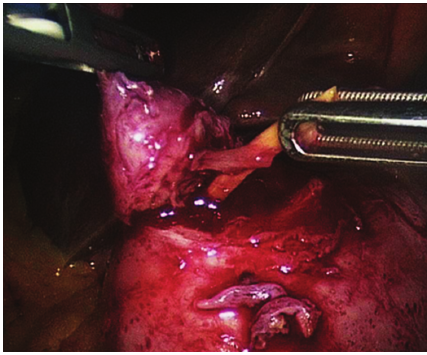
Figure 2: Gastroscopy: presence of a submucosal antral mass causing extrinsic compression on the gastric lumen without a discrete mucosal lesion.